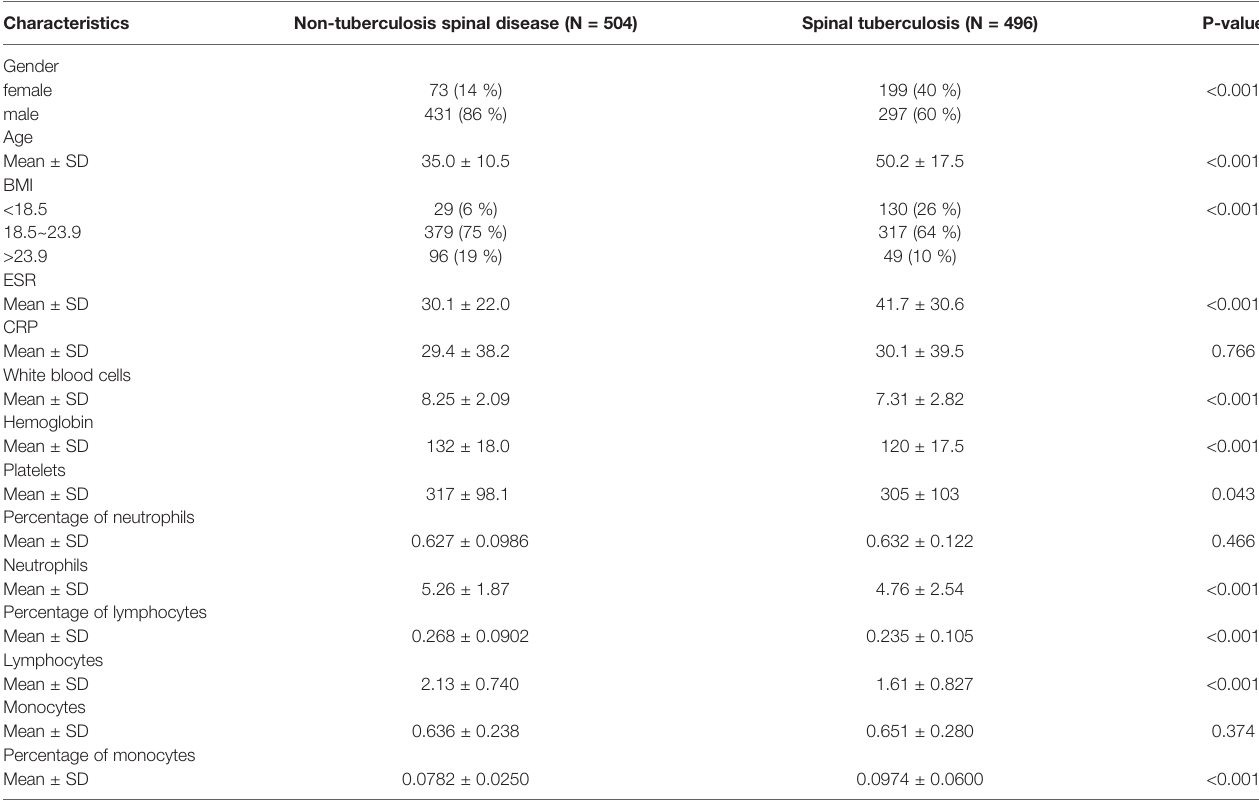
TABLE 1 | Clinical characteristics of patients in the spinal tuberculosis and the non-spinal tuberculosis.